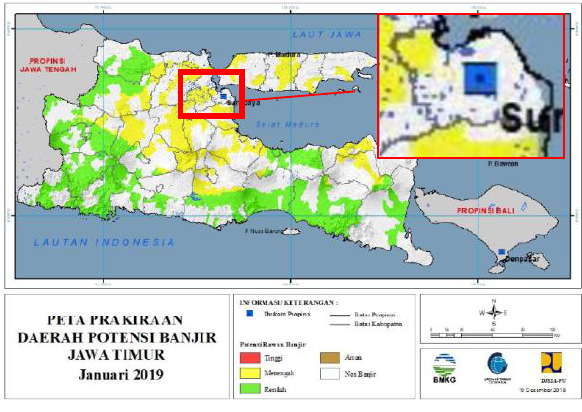
Figure 1. Flood Potential Map of East Java, Indonesia Based on the geographical location of Surabaya whose coastal area around, flood periodically occurs in particular area. Figure 1 shows flood potential map of East Java for January 2019. The severity level is divided into high, medium, and slight, indicated by red, yellow, and green respectively.